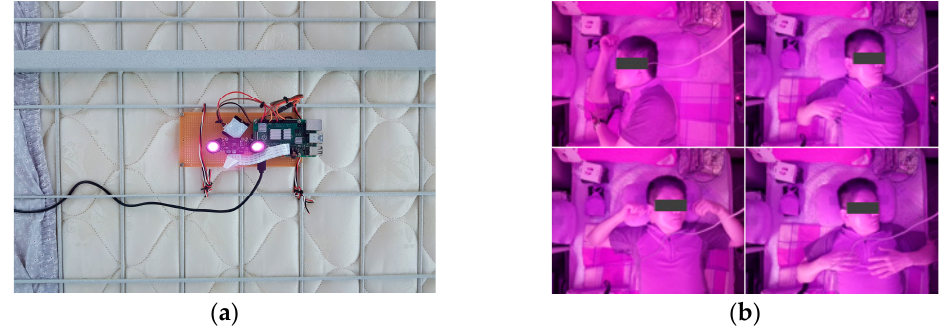
Figure 5. Sampling of sleeping posture images using an infrared camera. ( a ) Infrared camera module; ( b ) sleep posture images.